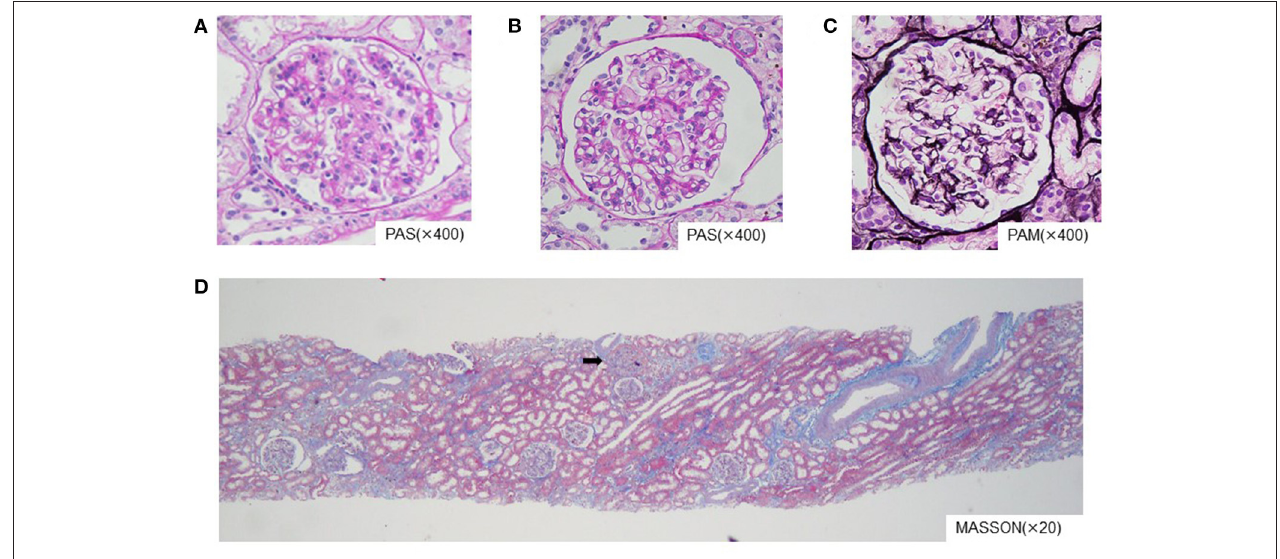
FIGURE 2 | Pathological findings (optical microscopy). (A,B) Two different glomeruli at 400x of PAS. (C) Glomerulus at 400x of PAM. (D) Kidney tissue at 20x of MASSON. The changes in the basement membrane of the hoof were minimal, mesangial proliferation was partial, and fibrosis was observed in only 10% of the cases. No membranoproliferative glomerulonephritis-like findings were observed in the chronic phase of impaired TMA, and there were only two sclerotic glomeruli (arrow) out of 18. PAS, periodic acid Schiff stain; PAM, periodic acid-methenamine-silver stain; MASSON, masson trichrome